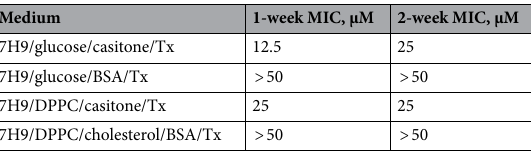
Table 4. MIC values for compound 27 against M. tuberculosis H37Rv strain in different